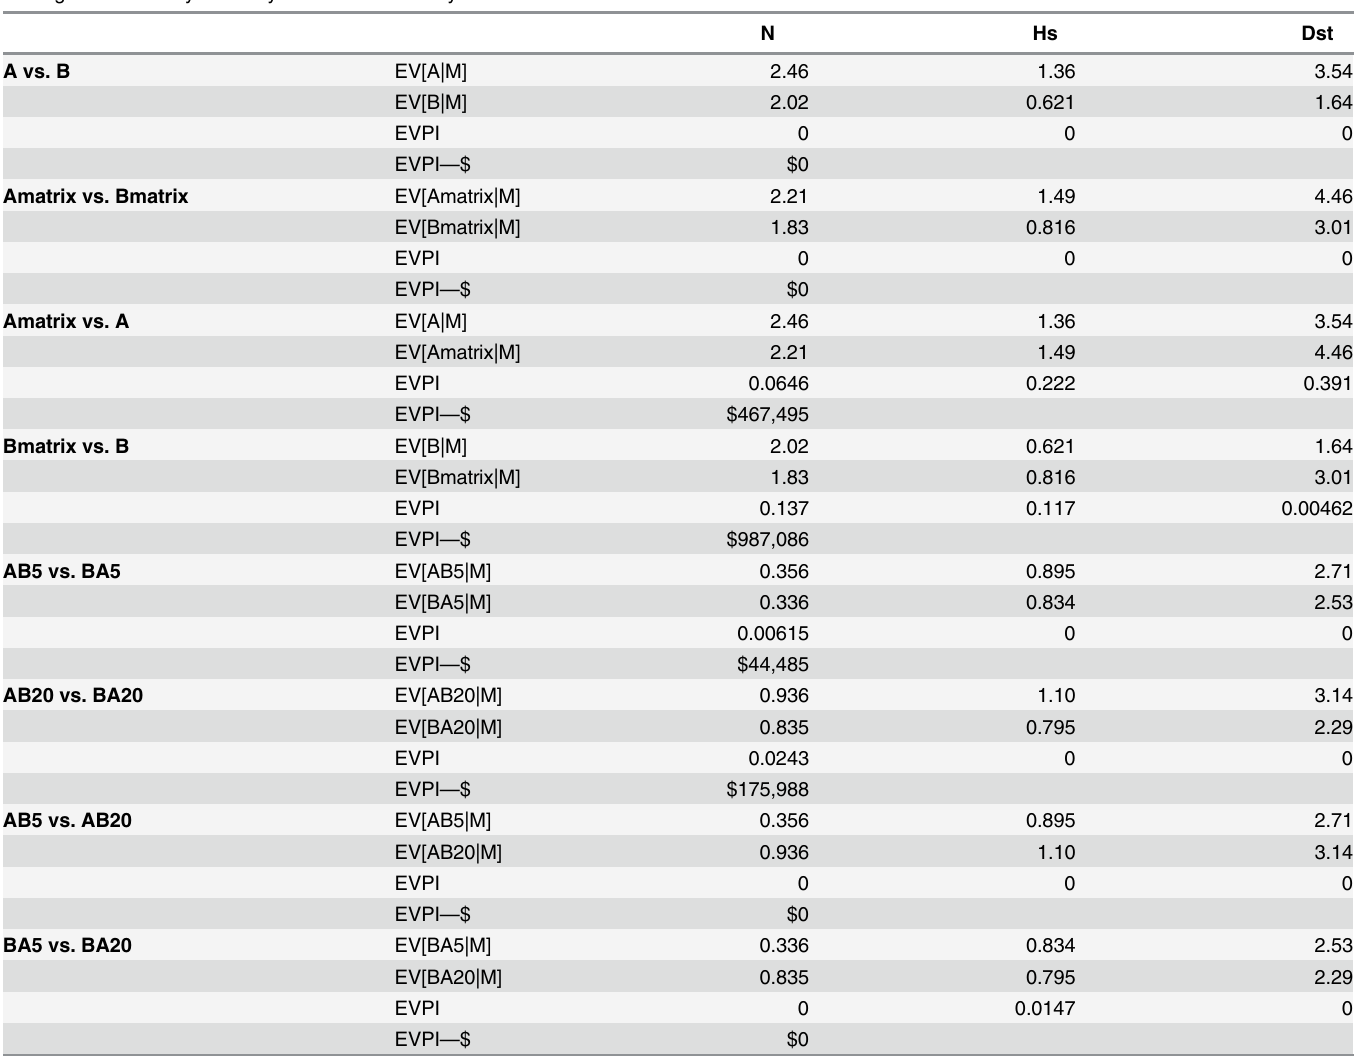
Table 2. Results of Decision Analysis to determine the Expected Value of Perfect Information regarding how land use affects dispersal behaviors. Values are estimated as LSYs remaining and as financial values assuming the price of a credit for abundance (LSY N) is $7,231,200. Financial value of cred- its for genetic diversity has not yet been estimated by these